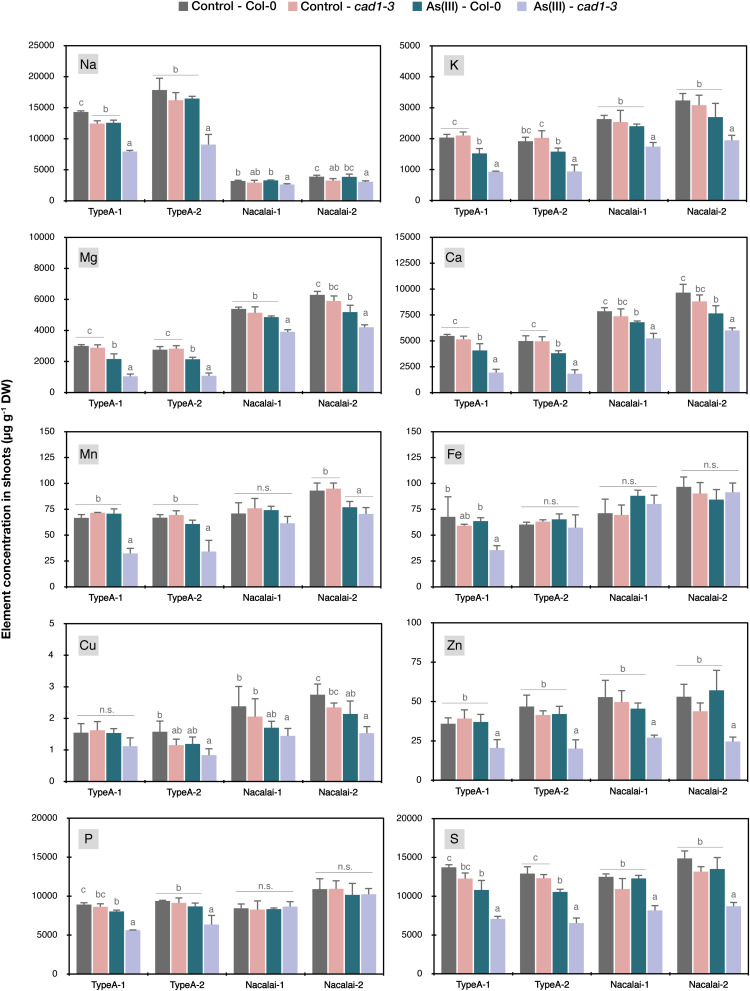
Ionomic profiles in shoots of Col-0 and cad1-3 under normal conditions and As(III) stressed conditions. Plants were grown on the control medium prepared with the respective agar reagents for 10 days and then transferred to the fresh control medium or the medium containing 5 μM As(III). After 4 days, plants were harvested and concentrations of Na, K, Mg, Ca, Mn, Fe, Cu, Zn, P, and S in shoots were quantified by ICP-OES. Data represent means with SD from two independent experiments (n = 4). Means sharing the same letter are not significantly different within each agar reagent (P < 0.05, Tukey’s HSD).